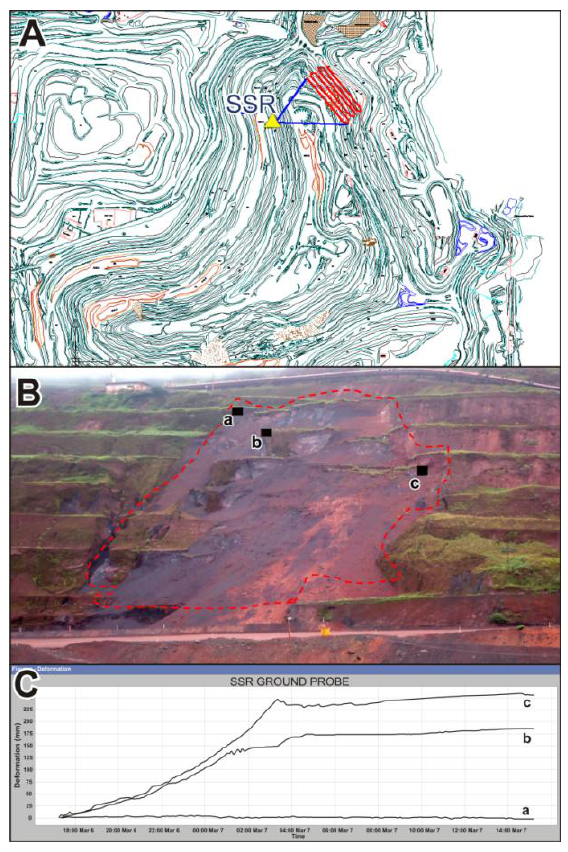
Figure 5. (A) SSR configuration used for monitoring cut slopes in the NNE flank of N4E mine. (B) Field picture showing rockfalls and location of specific points measured by SSR on bench walls (letters a, b, c). (C) SSR deformation profiles related to points a, b, c.